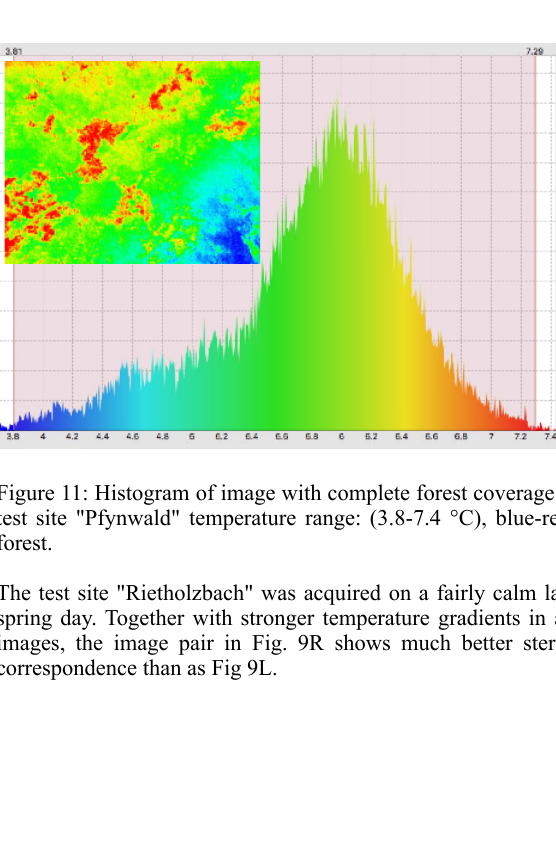
Figure 8. Thermal image at test site "Pfynwald" (blue: GCP target, red: human) with tie points (dots), temperature range: 2-11 °C (heat-map colors blue-cyan-green-yellow-red). Tie points have been extracted with PSP with the step "Align Photos" in the PSP workflow. The found points at the test site "Pfynwald" are only found on the ground (yellow regions in Fig. 8), but not in the canopy region. The strong and gusty wind during the flight campaign, combined with unusually low temperatures result in an insufficient number and also unfavorable distribution of tie points.